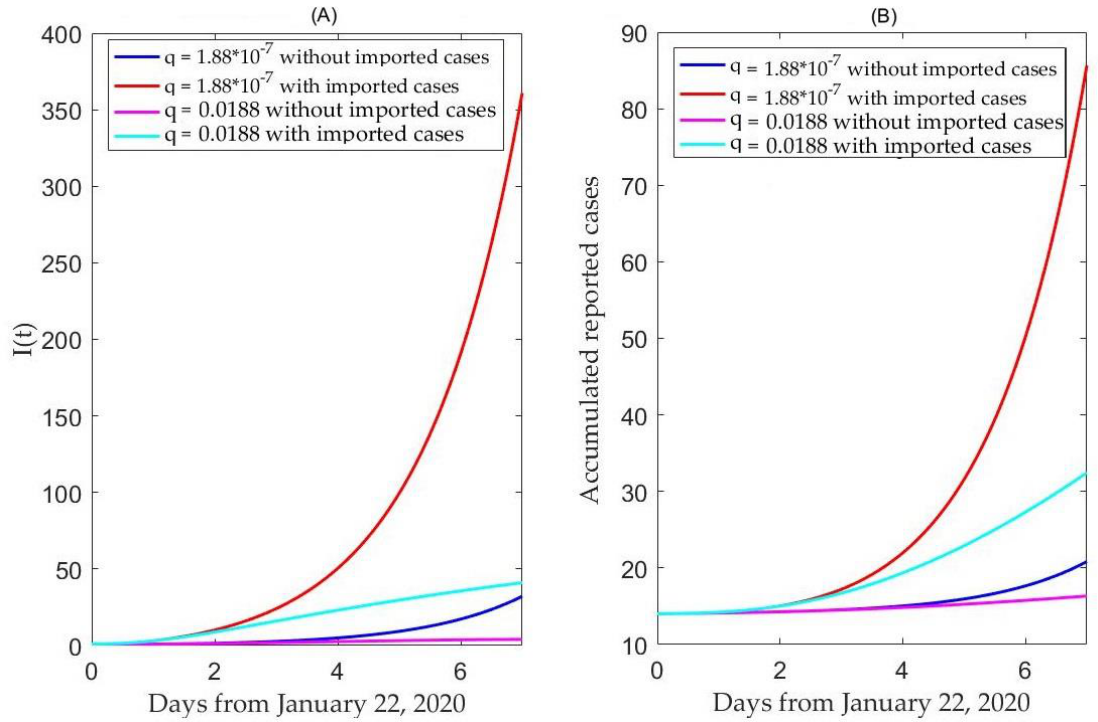
Figure 6. The effects of no travel restrictions ( A ) versus travel restriction ( B ) in the Hubei Province on the Coronavirus disease in Beijing city.